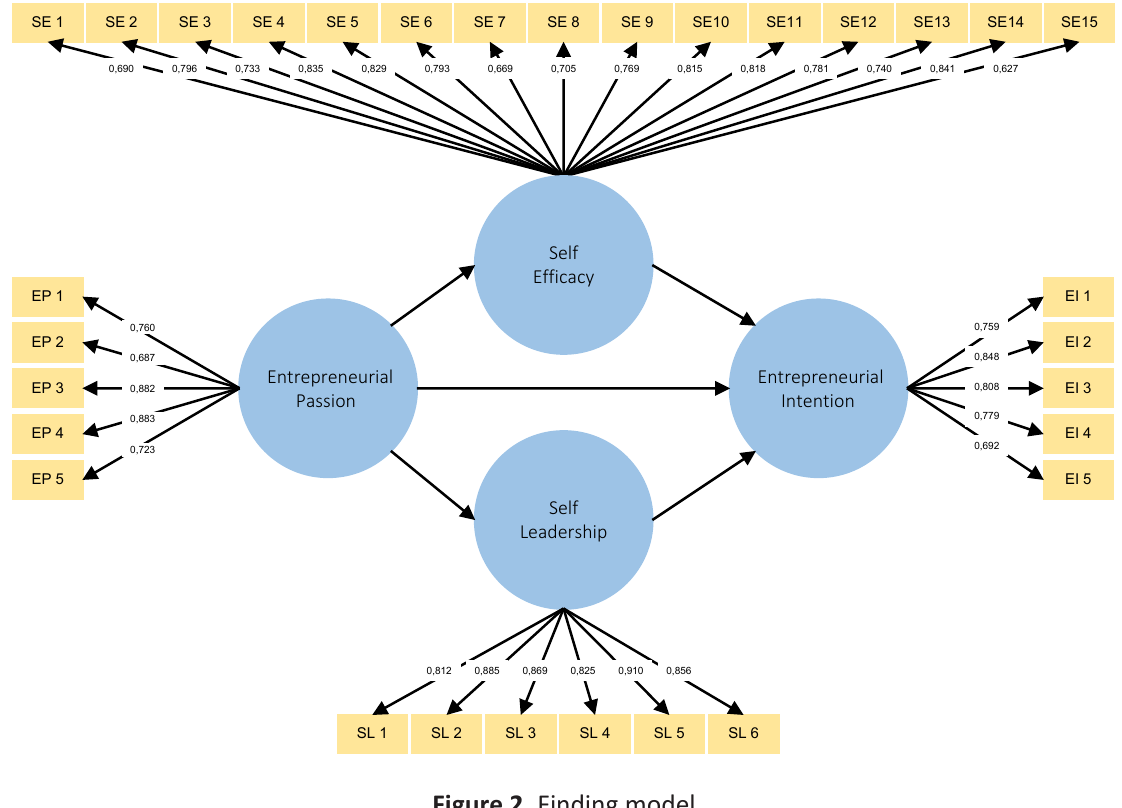
Figure 2. Finding